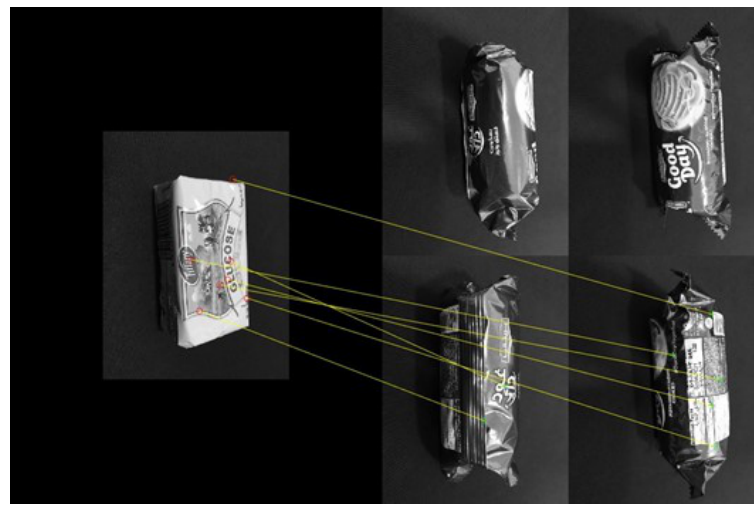
Figure 19. Feature matching process of different items.